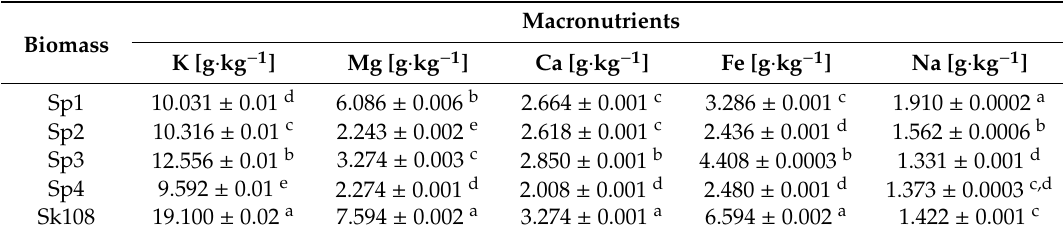
Table 3. Contents of macronutrients in methanotrophic biomass.